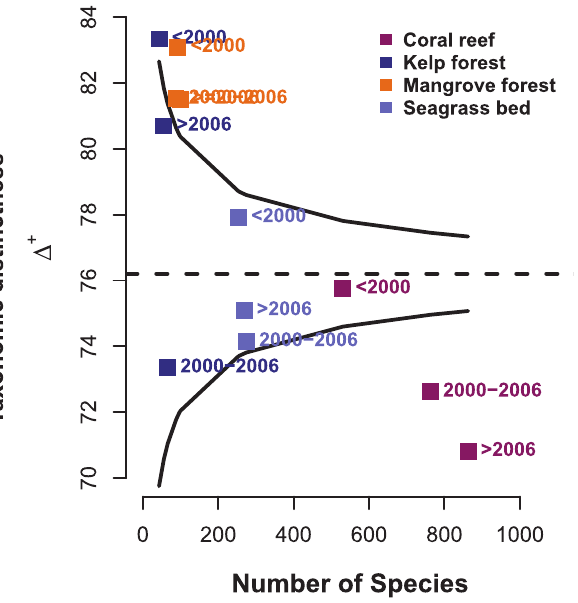
Figure 2. Taxonomic distinctness of WebofScience H literature for four marine ecosystems. Taxonomic distinctness ( D + ) plotted against the number of species for three time periods (prior to 2000, 2000–2006 and 2007–2009) across four marine ecosystems. The dashed line denotes the simulated mean and solid lines (funnel) indicate the approximate 2*standard deviation limits. Points falling outside the 2*standard deviation limit can be considered ‘significantly’ higher (greater taxonomic breadth present above) or lower (less taxonomic breadth present, below) than the simulated mean.